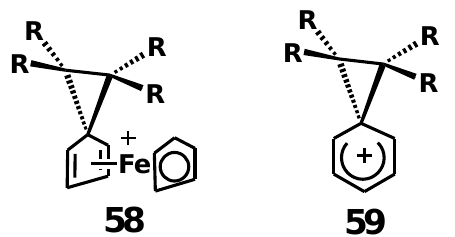
Figure 3. Transition states for ferrocenyl and phenyl rearrangements whereby positive charge is delocalized onto the migrating group.